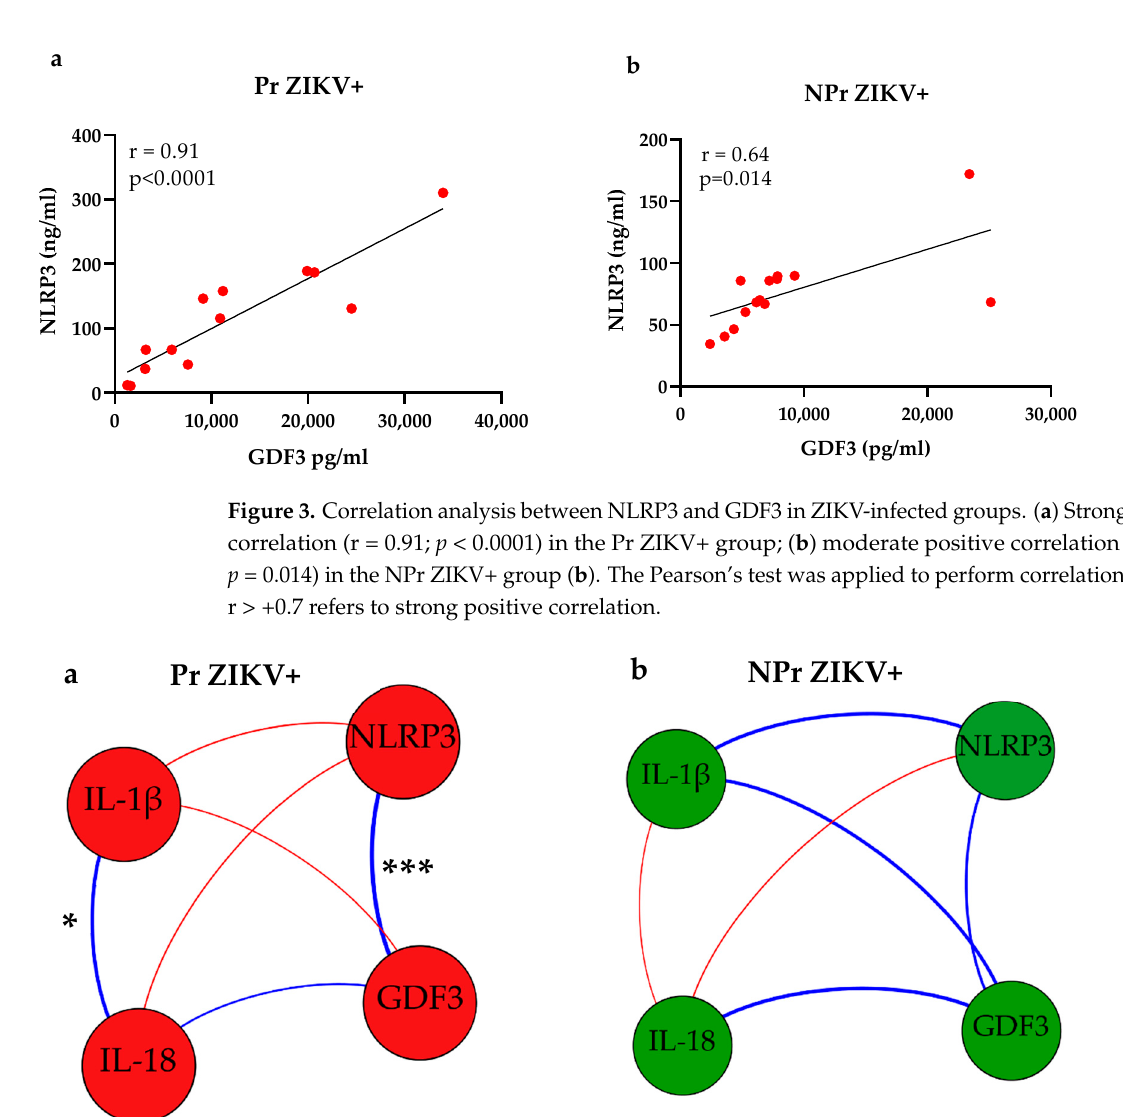
Figure 4. Multivariate correlation analysis of NLRP3, GDF3, IL-1 β , and IL-18 in ZIKV-infected groups. ( a ) correlation among ZIKV-infected pregnant women (Pr ZIKV+); ( b ) correlation among ZIKV-infected non-pregnant women (NPr ZIKV+). Thick lines indicate strong correlation and thin lines indicate weak correlation. Blue lines refer to a positive correlation and red lines refer to a negative correlation. *** p < 0.001, * p < 0.05.